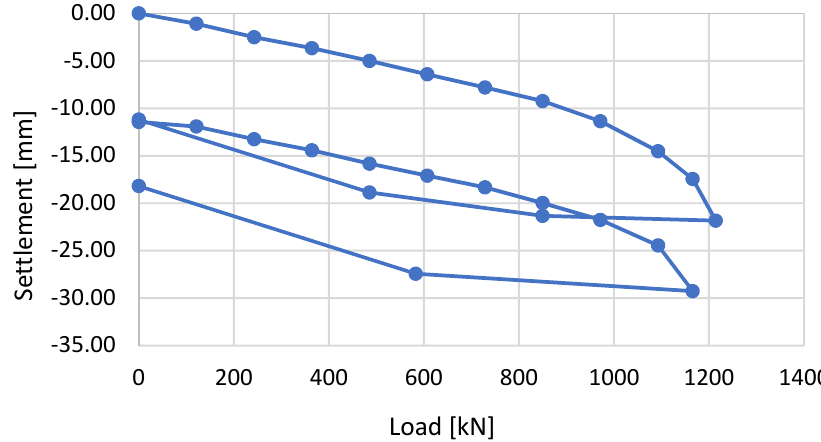
Figure 7. Load versus settlement curve from the SLT in two cycles of loading on the basis of dial gauges measurement.